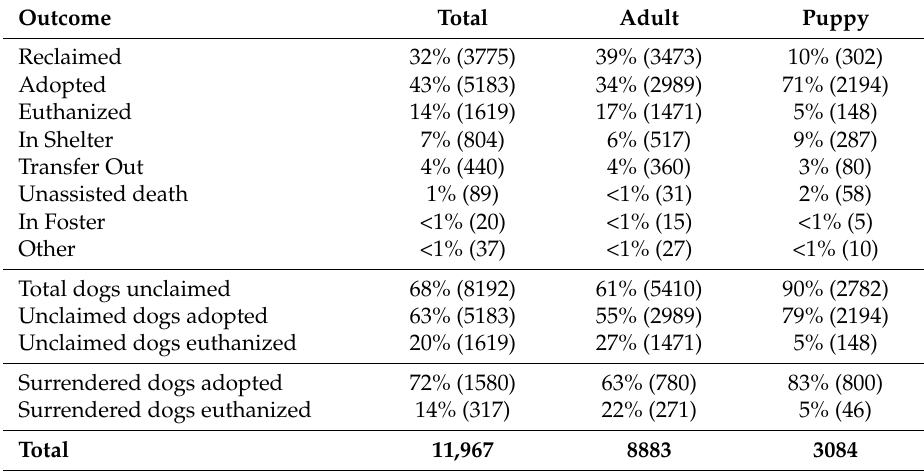
Table 7. Summary of age group and outcome of 11,967 dogs processed through RSPCA Queensland shelters in 2014.